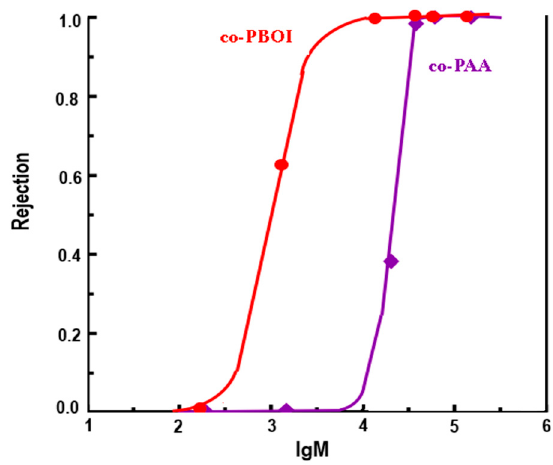
Figure 9. Dependence of proteins rejection on their molecular weights in ultrafiltration using co-PAA and co-PBOI membranes.